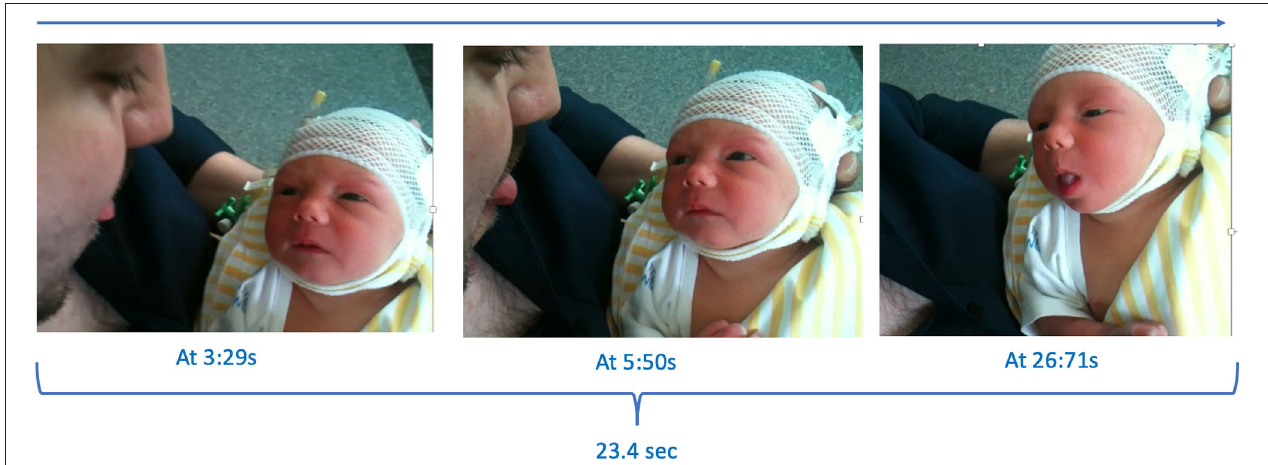
FIGURE 3 | A sequence of still photos (courtesy of the family) from the home video showing Marcus’ response. Tongue protrusion is defined as a clear forward movement of the tongue even if the tongue was not protruded beyond the outer part of the lips (see Heimann and Tjus,